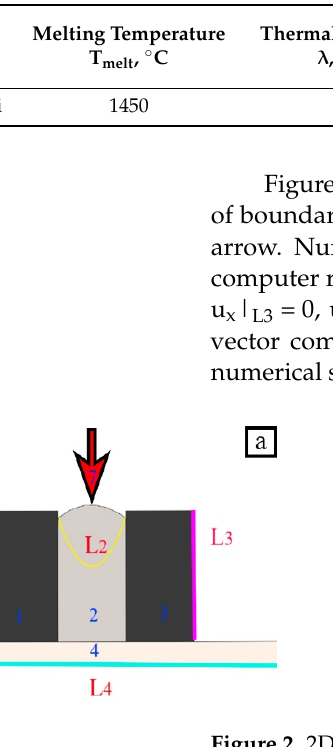
Table 2. Properties of steel AISI 308LSi.